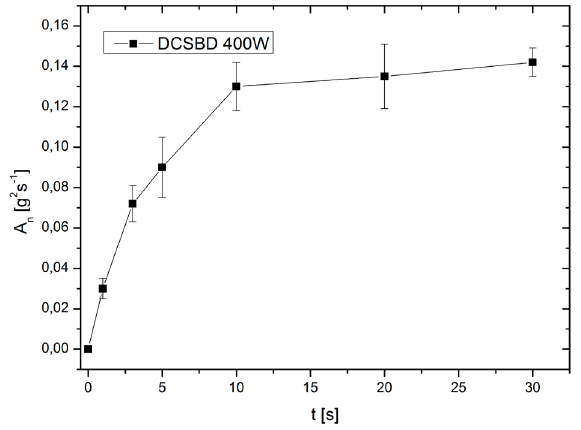
(normalized specic rate of wetting) for PP fibres treated in Figure 7: A n DCSBD with various exposure times.